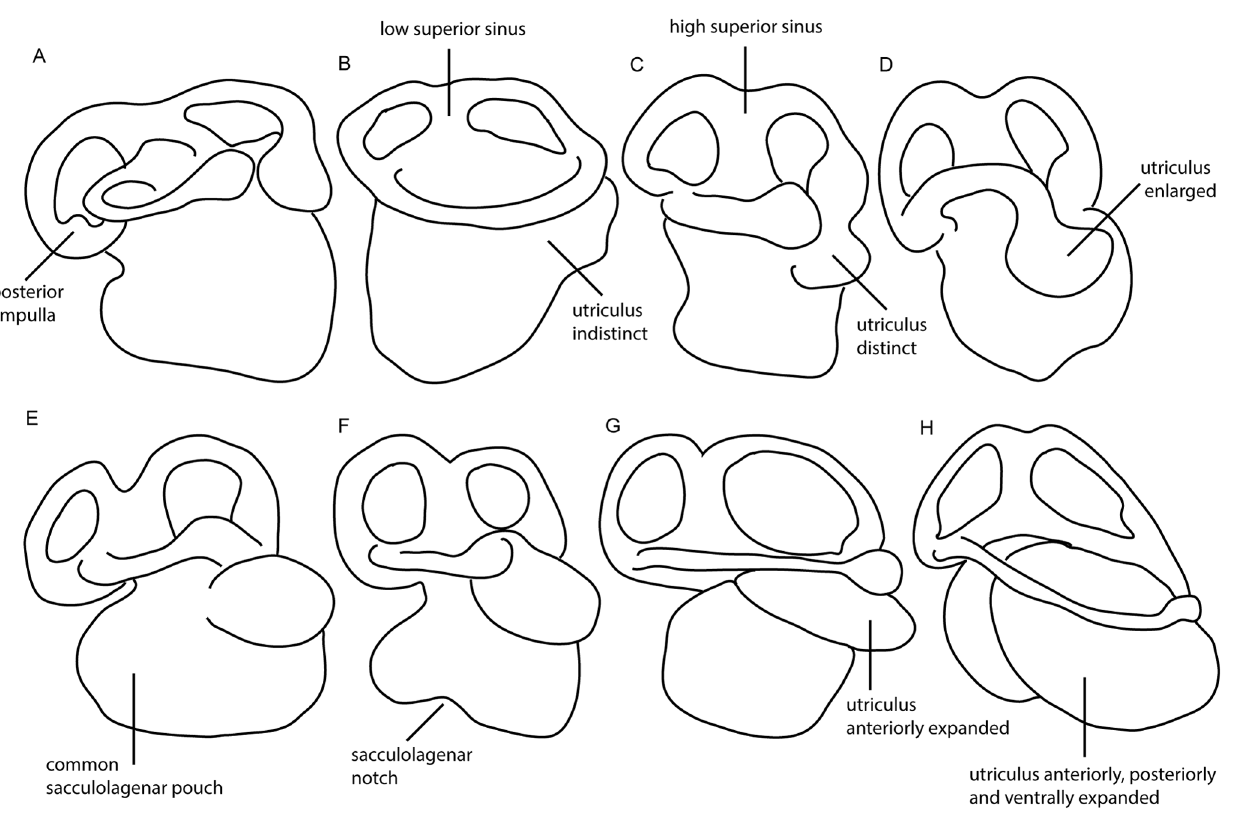
Figure 4. Labyrinth region morphology of eight dipnomorphs. A, Youngolepis praecursor (from Chang [25], fig. 19); B, Dipnorhynchus sussmilchi (from Campbell and Barwick [22], fig. 25); C, ‘ Chirodipterus’ australis (from Miles [52], fig. 48); D, Chirodipterus wildungensis (from Sa¨ve-So¨derbergh [21], fig. 9); E, Griphognathus whitei (from Miles [52], fig. 46); F, Rhinodipterus kimberleyensis (WAM 09.6.149); G, Neoceratodus forsteri ; and H, Protopterus annectens (both from Retzius [51], plate XXIV). Not to scale, anterior is to the